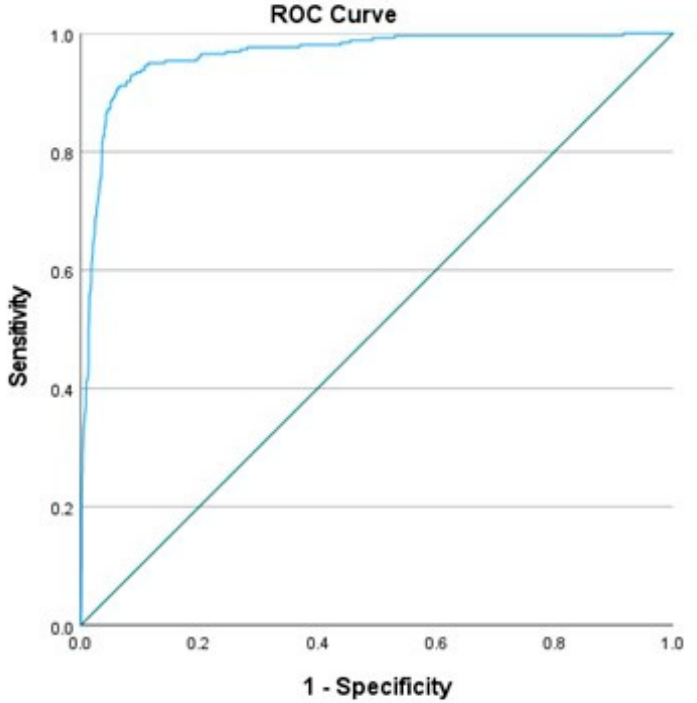
Figure 1. ROC curve representing the discriminatory ability of Equation (1) on the task of detecting un/accented syllables.